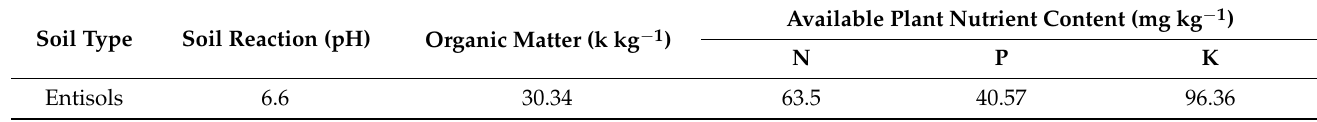
Table 2. Basic information of the soil in the experimental area (in the top soil layer (0–20 cm)). Soil Type Soil Reaction